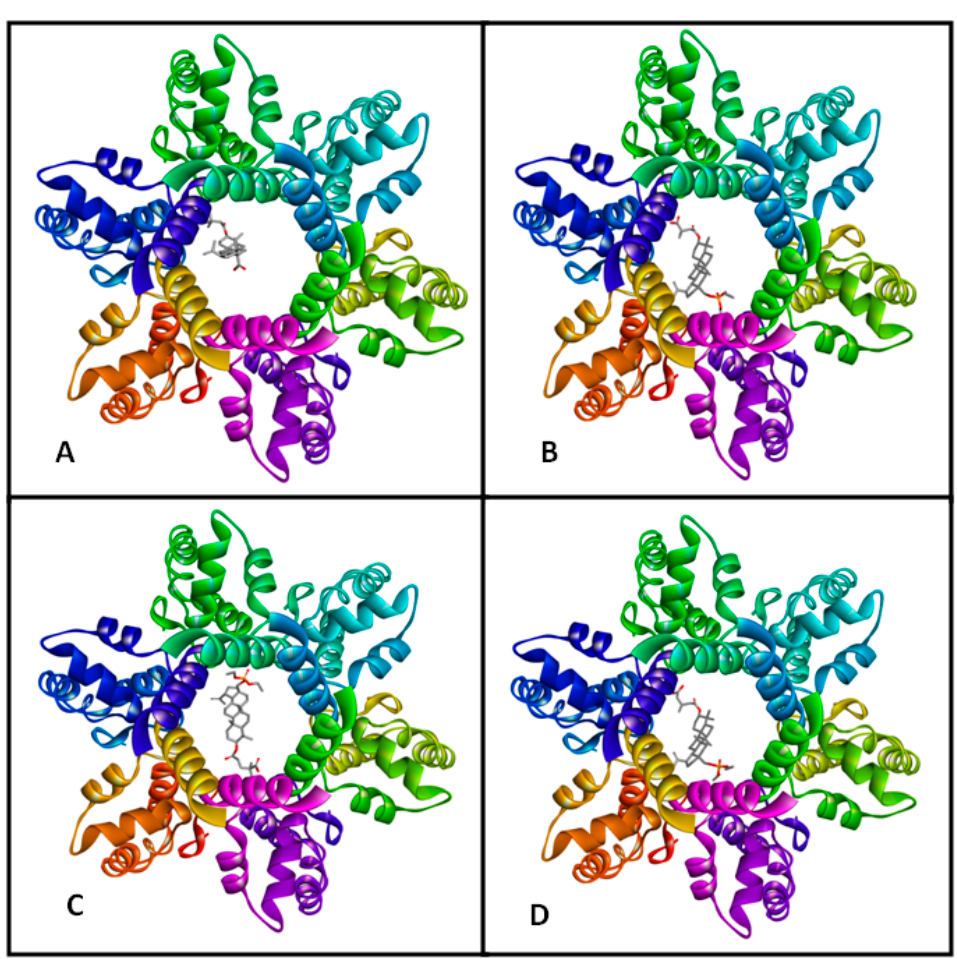
Figure 1. Predicted binding model of bevirimat ( BVM ) ( A ) and compounds 3 − 5 (( B − D ), respectively) with HIV-1 capsid (CA) C-terminal domain (CTD)-spacer peptide 1 (SP1) protein.